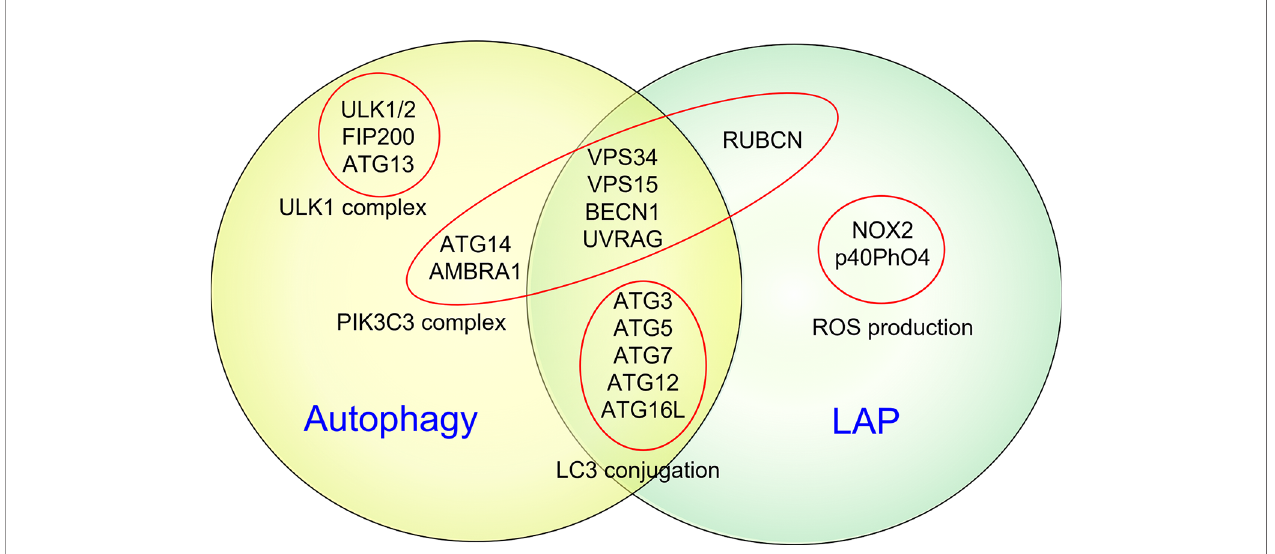
FIGURE 2 | Autophagy and LAP share several key molecular regulators and machinery. It is now widely acknowledged that some common components of the autophagic machinery, especially constituents of the PIK3C3 complex, are shared by autophagy and LAP. Unlike autophagy, LAP is an autophagosome- independent process that occurs independently of the mTOR substrate complex (ULK1/2, ATG13, RB1CC1/FIP200, and ATG101) but relies on RUBCN, CYBB/ NOX2, and the WD domain of ATG16L1, which are all dispensable for